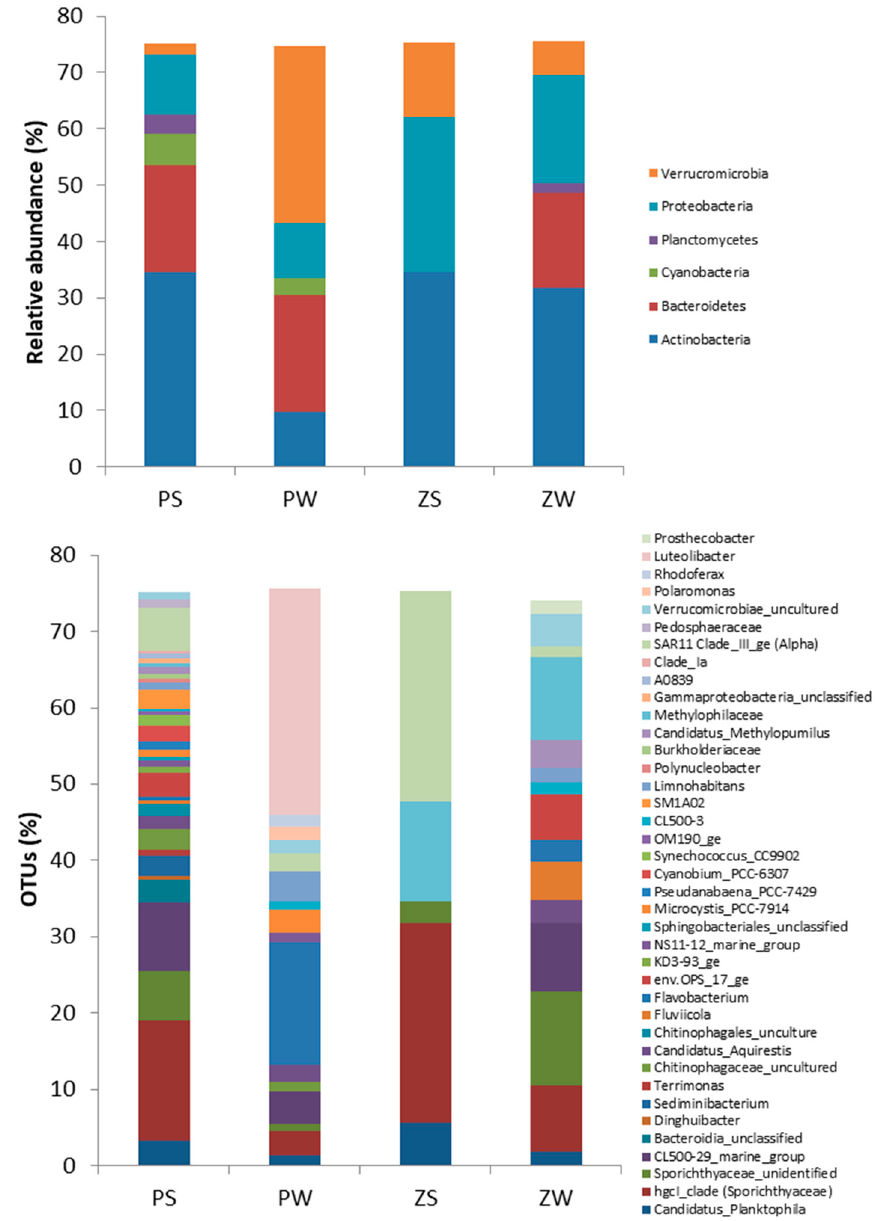
Figure 3. Relative abundance of dominant phyla and OTUs in Pamvotis (P) and Ziros (Z) Lakes in summer (S) and winter (W). 208